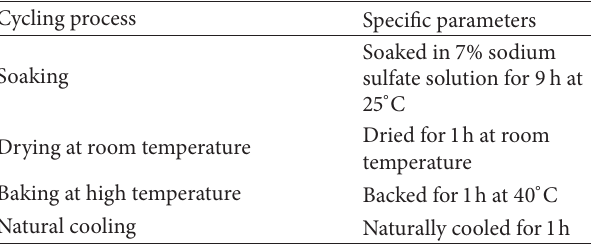
Table 3: System of dry-wet cycling test.